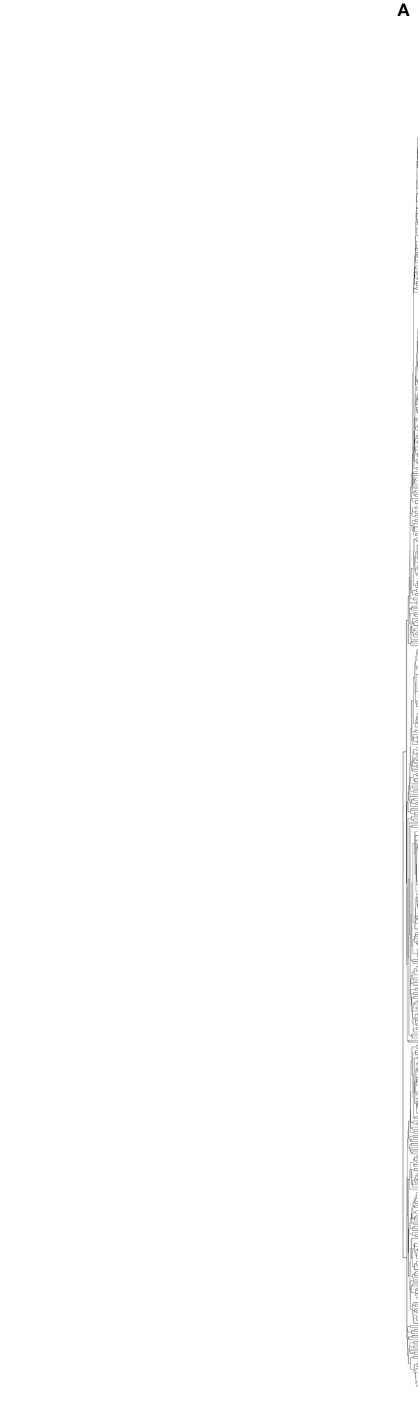
FIGURE 2 | Cluster analysis of differentially expressed proteins in the group of Ca_vs_CaP and Cs_vs_Cr. The hierarchical clustering results are represented as a tree heat map, with the ordinate representing signi fi cantly differentially expressed proteins and the abscissa representing sample information. Signi fi cant differences in protein expression in the different numerical expression quantities (log2 expression) of the samples with different colors are shown in the heat map, where red represents signi fi cantly upregulated proteins, blue represents signi fi cantly downregulated proteins, and gray represents no quantitative information for